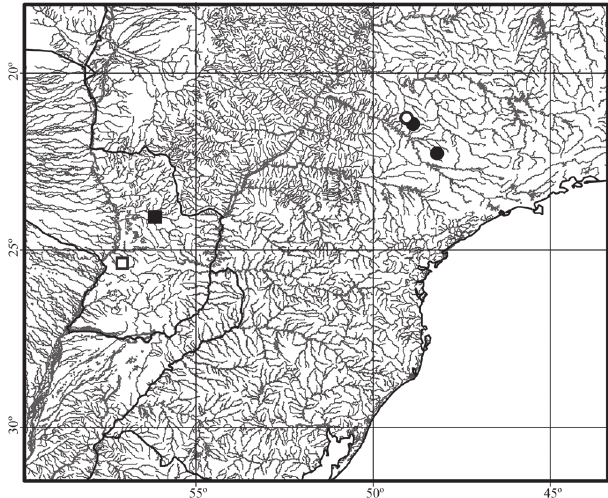
Fig. 6. Otothyropsis piribebuy , sexual dimorphism in the size of the nostrils. a . Female, paratype, MCP 44394, 24.4 mm SL. b . Male, paratype, MCP 44394, 26.9 mm SL. Scale bar = 1 mm.